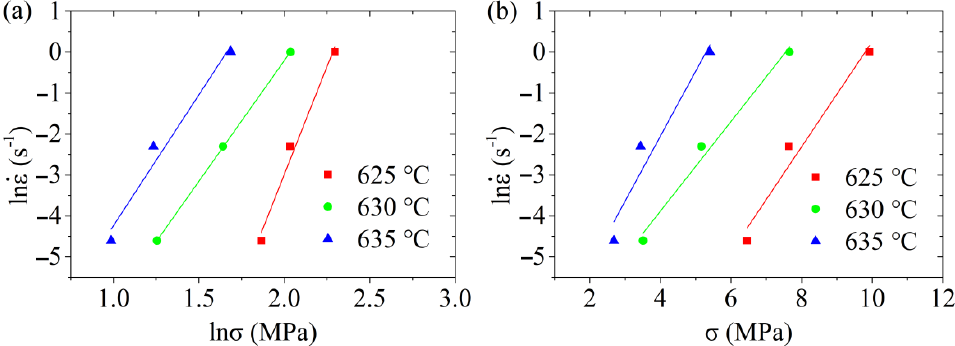
Figure 7. Relationship between the natural logarithm of the strain rate, and ( a ) the natural logarithm of the peak stress, and ( b ) the peak